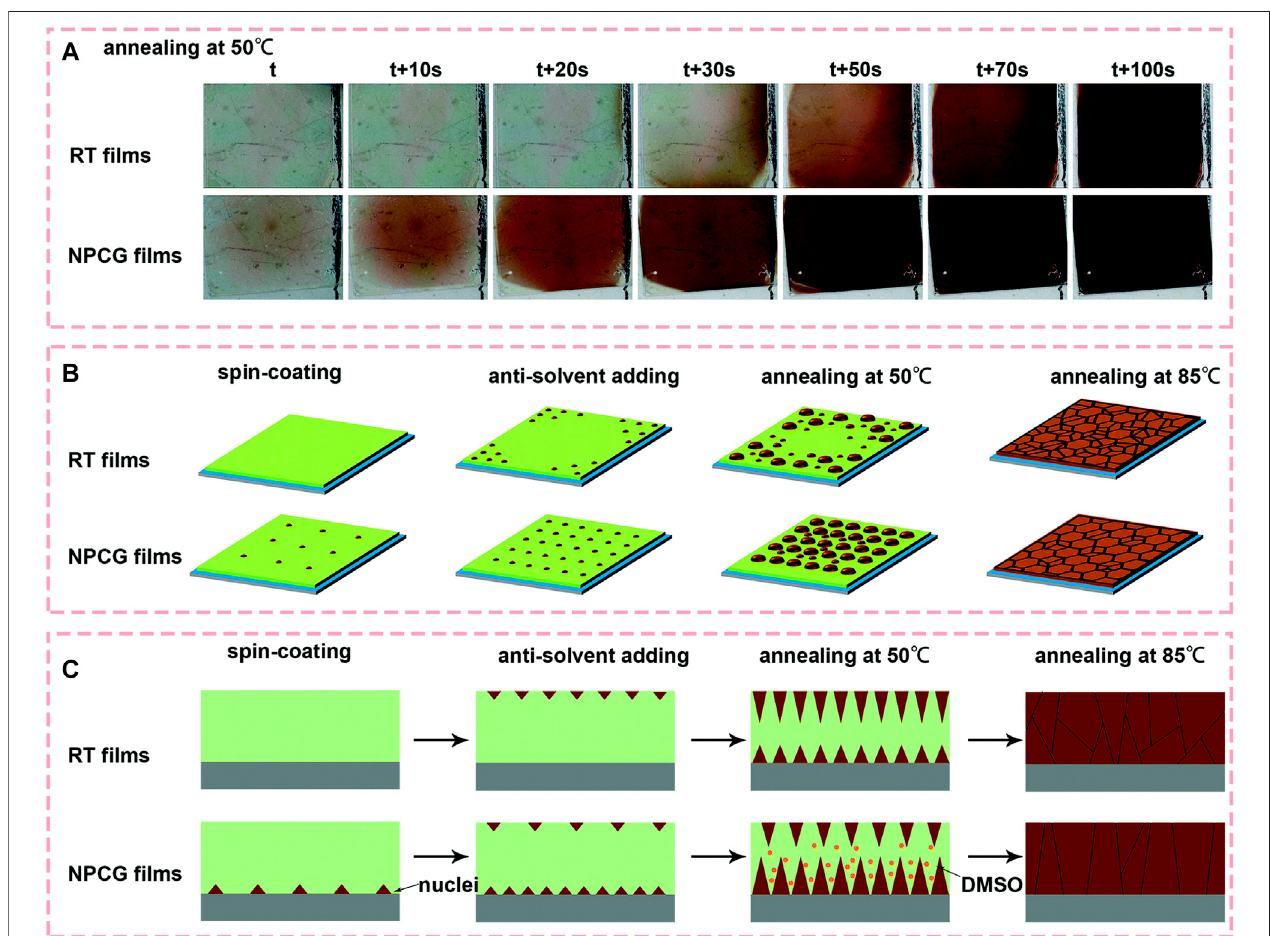
FIGURE 3 | (A) Photos recorded during thermal annealing of the perovskite fi lms using NPCG@0 and RT methods at a temperature of 50 ° C. Illustration of the nucleation and growth of the grains for the fi lms fabricated using NPCG and RT methods at each stage, (B) top view and (C) cross-sectional view. Reproduced with permission (Kang and Park, 2019). Copyright 2019, The Royal Society of